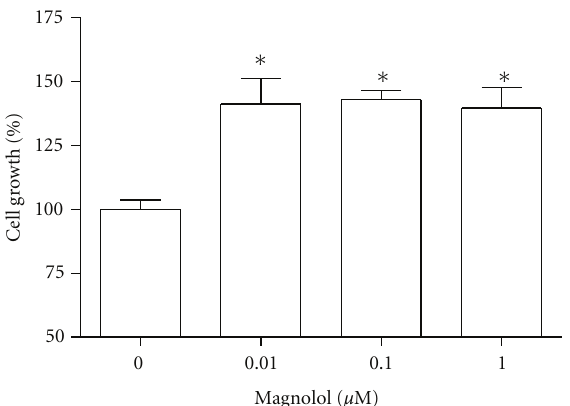
Figure 1: E ff ect of magnolol on the growth of MC3T3-E1 cells. Data were expressed as a percentage of control. ∗ P < 0 . 05 compared with control.